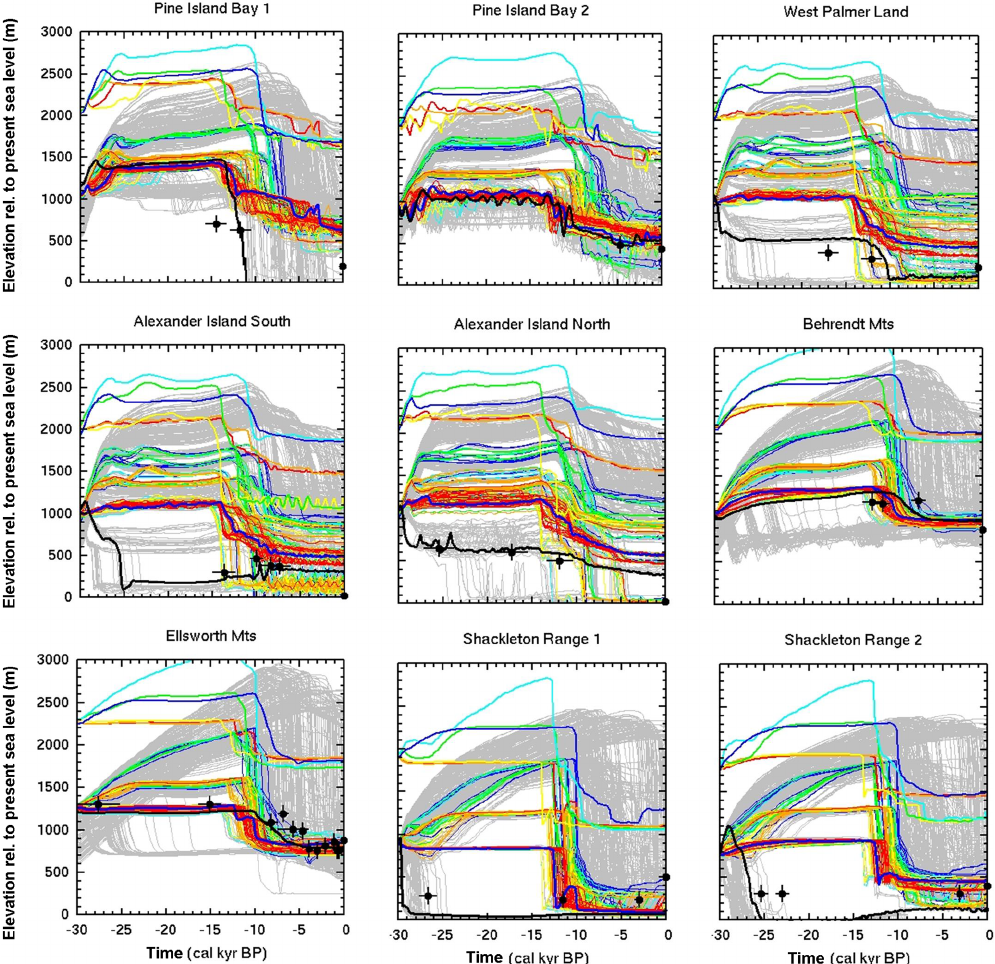
Figure D2. Model vs. observed elevation vs. age data, for the 18 sites in the compilation (Briggs and Tarasov, 2013) that lie within and away from the edges of the model’s West Antarctic domain, shown roughly in west-to-east order. The observations and uncertainty ranges are shown as black dots and whiskers. Model curves are shown for all 625 runs, with aggregate scores S indicated by colors as in Fig. 5. The run with the best individual score for each site is shown as a thick black line, and the run with the best aggregate score S is shown as a thick blue line. Sites shown (Briggs and Tarasov, 2013) are Reedy Glacier 1, ∼ 85.9 ◦ S, 132.6 ◦ W; Reedy Glacier 2, ∼ 86.1 ◦ S, 131.0 ◦ W; Reedy Glacier 3, ∼ 86.3 ◦ S, 126.1 ◦ W; Hatherton Glacier, ∼ 79.9 ◦ S, 156.8 ◦ E; Clark Mts, ∼ 77.3 ◦ S, 142.1 ◦ W; Allegheny Mts, ∼ 77.3 ◦ S, 143.3 ◦ W; Western Sarnoff Mts, ∼ 77.1 ◦ S, 145.5 ◦ W; Eastern Fosdick Mts, ∼ 76.5 ◦ S, 144.5 ◦ W; Executive Committee Range, ∼ 77.2 ◦ S, 127.1 ◦ W; Pine Island Bay 1, ∼ 75.2 ◦ S, 111.2 ◦ W; Pine Island Bay 2, ∼ 74.5 ◦ S, 99.2 ◦ W; West Palmer Land, ∼ 71.6 ◦ S, 67.4 ◦ W; Alexander Island South, ∼ 72.0 ◦ S, 68.5 ◦ W; Alexander Island North, ∼ 70.9 ◦ S, 68.4 ◦ W; Behrendt Mts, ∼ 75.3 ◦ S, 72.3 ◦ W; Ellsworth Mts, ∼ 80.3 ◦ S, 82.2 ◦ W; Shackleton Range 1, ∼ 80.4 ◦ S, 30.1 ◦ W; and Shackleton Range 2, ∼ 80.1 ◦ S, 25.8 ◦